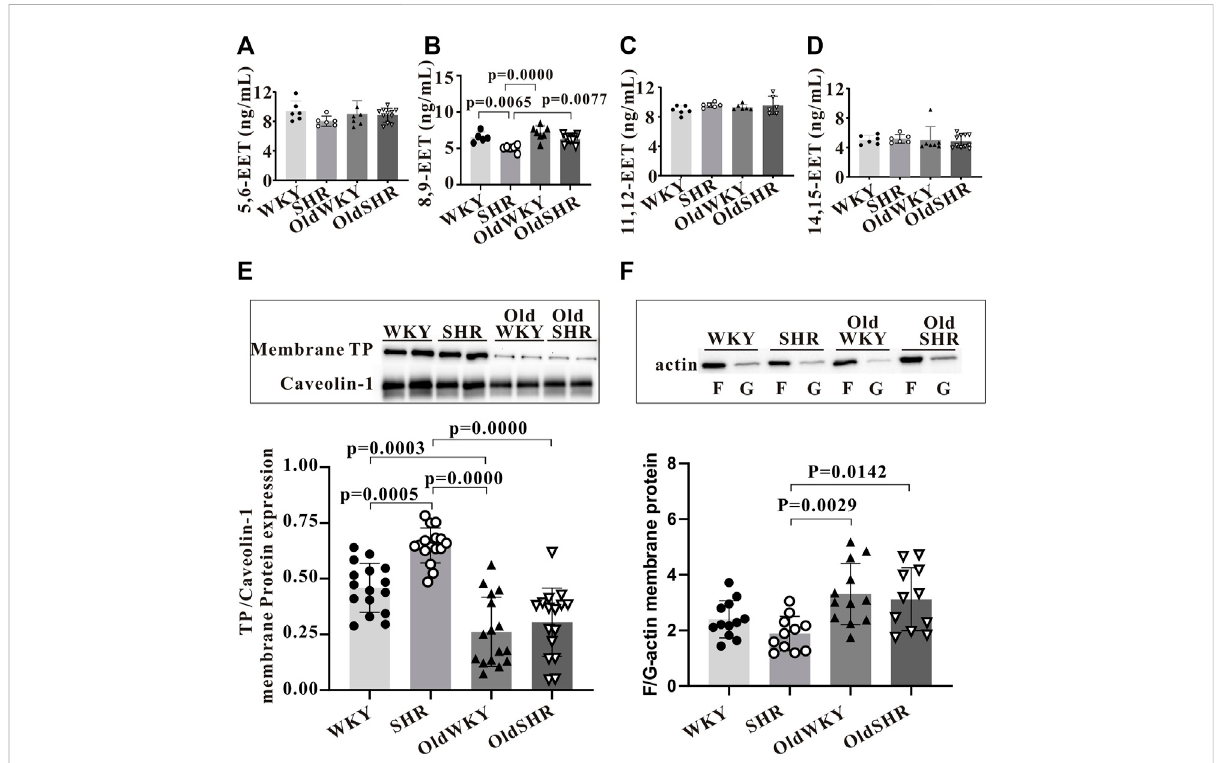
FIGURE 6 Expression of TP desensitization or endocytosis-related proteins. (A – D) Expression of EET subtypes in serum by ELISA. Summary data showing that8,9-EETserumlevelsweresigni fi cantlyhigherintheOldWKYandOldSHRgroupsthanintheSHRgroup( p < 0.001and p < 0.01,respectively). (E) Western blot showing that expression of TP on the cell surface was signi fi cantly decreased in OldWKY or OldSHR rats ( p < 0.001). (F) F/G-actin protein expression showing that F/G-actin ratio in mesenteric arteries of OldWKY or OldSHR rats was signi fi cantly increased, compared with SHR rats ( p < 0.01 or p < 0.05). Intact mesentery arteries were collected from 5 – 11 rats in each